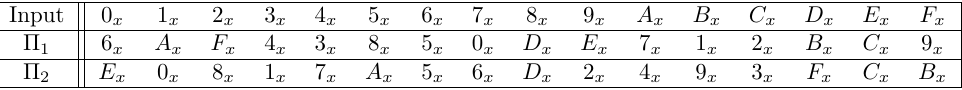
Table 3: The proposed S-boxes for GOST2